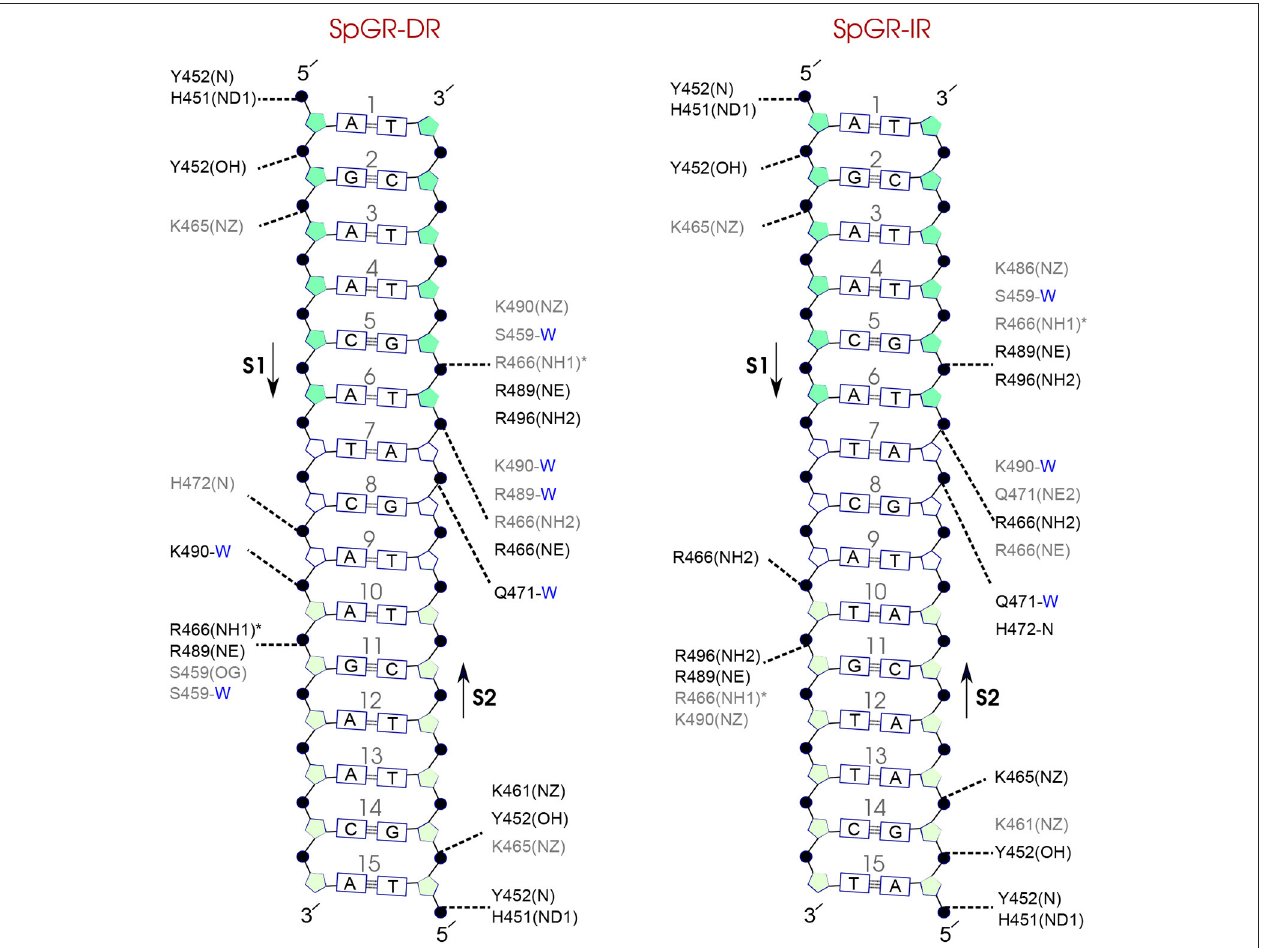
FIGURE 9 | Diagram of protein-DNA hydrogen-bond interactions for (left) SpGR-DR and (right) SpGR-IR. The nucleotides of the 15 bps core DNA sequence are numbered from HS1 (numbers: 1–6) to HS2 (numbers: 10–15). The spacer region is highlighted with non-colored boxes around the numbers of the bases (numbers: 7–9). The hydrogen bonds are categorized based on their occupancy, 50–75% (gray), and 75–100% (black). The water mediated hydrogen bonds are shown with a blue letter “W.” The residues shown with star sign form base-specific hydrogen-bond interactions while the other residues interact with the backbone of the